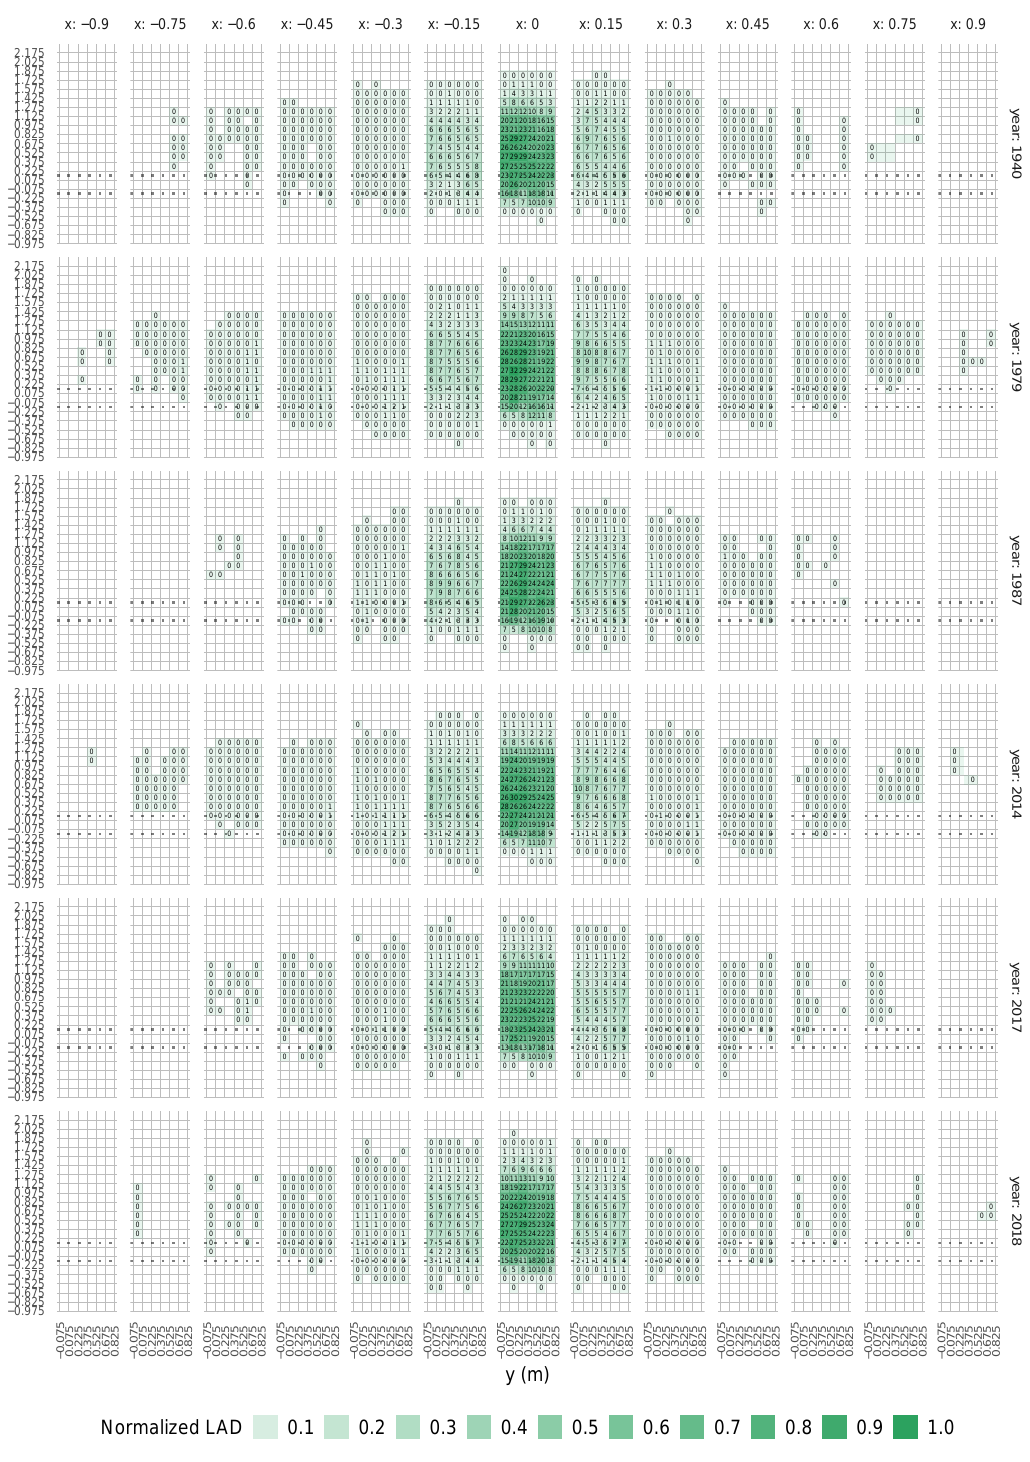
Figure 17. Leaf area density (LAD, m 2 m − 3 ) for cubes of 0.003375m 3 (15cm × 15cm × 15cm) at final simulation dates (i.e., 90% ≥ 2.3m) per simulation year. Opacity: normalised LAD (LAD/ max ( LAD ) ; side view of canopy: cane/canopy aligned with y -axis; x : distance to cane; y : distance along cane/canopy; z : height relative to centre of bunch zone; dotted line: bunch